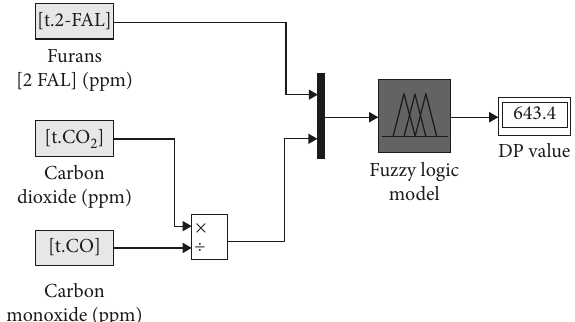
Figure 1: Fuzzy logic model for DP estimation.